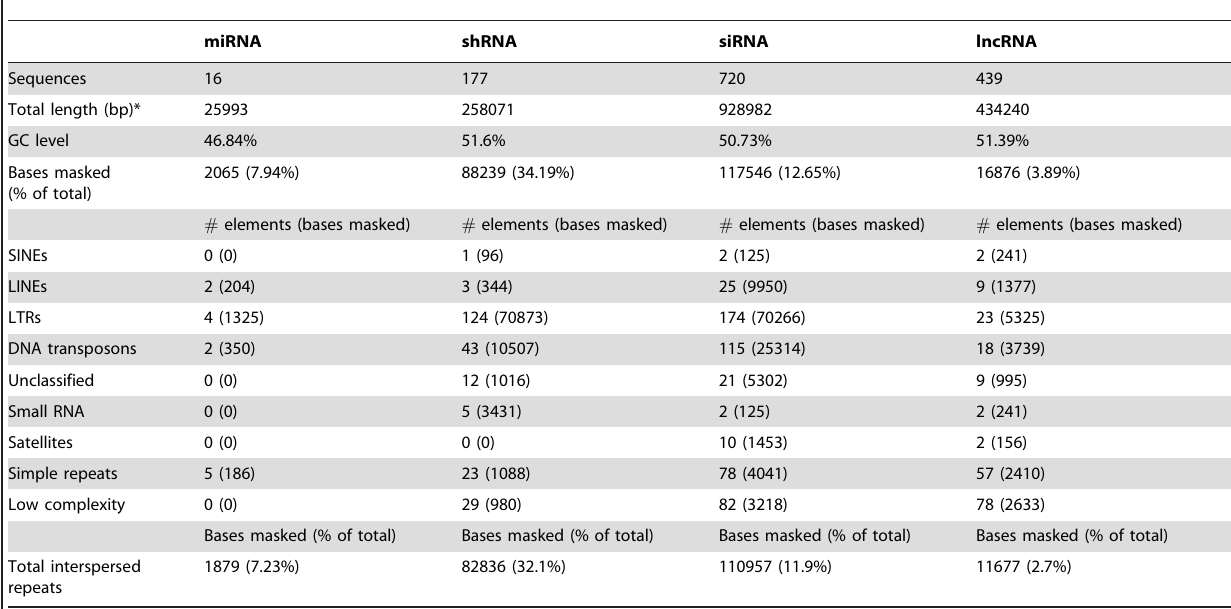
Table 6. Repetitive element content of intergenic lncRNA candidates by